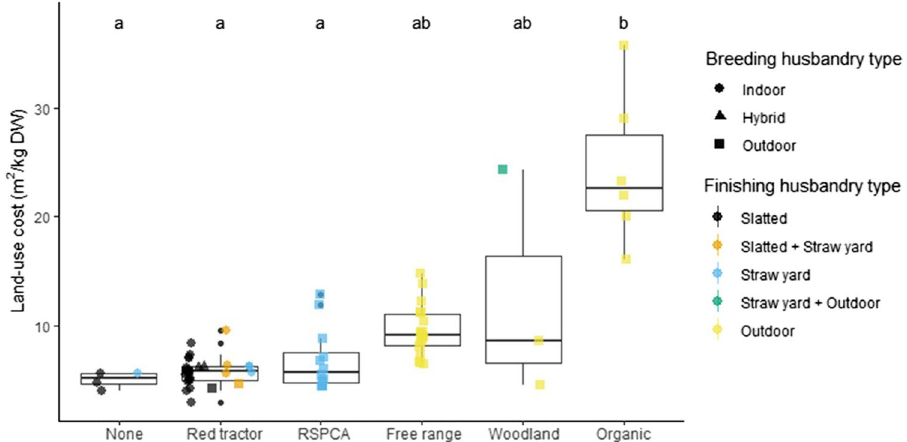
Figure 1. The land-use costs of breed-to-finish systems by label type, which includes land to rear animals and produce feed. The shapes and colours of scattered points show the husbandry type of breeding and finishing systems respectively. The letters above boxplots show the results from Dunn’s post-hoc tests, controlled for multiple comparisons using the Holm method, with different letters indicating significant differences between median values. The upper and lower hinges correspond to the first and third quartiles. Upper and lower whiskers extend to 1.5 times the interquartile range from upper and lower hinges respectively. The middle horizontal bar is the median. The smaller solid black dots refer to outliers which are any points that lie beyond the whiskers.